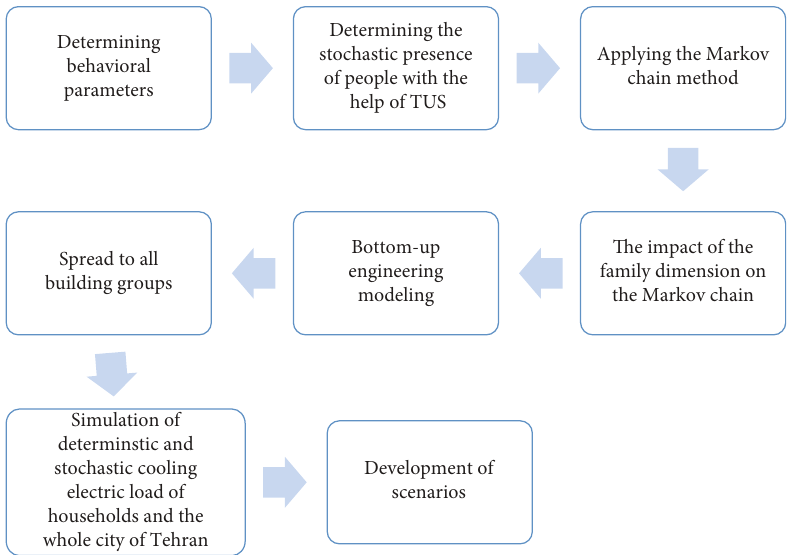
Figure 10: The process of stochastic and agent base modeling (behavioral and